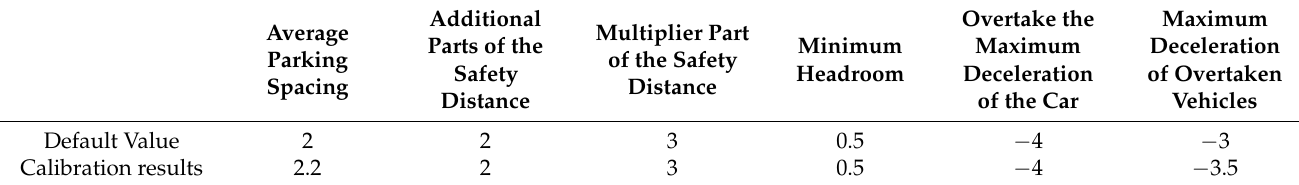
Table 2. Calibration results of driving behavior